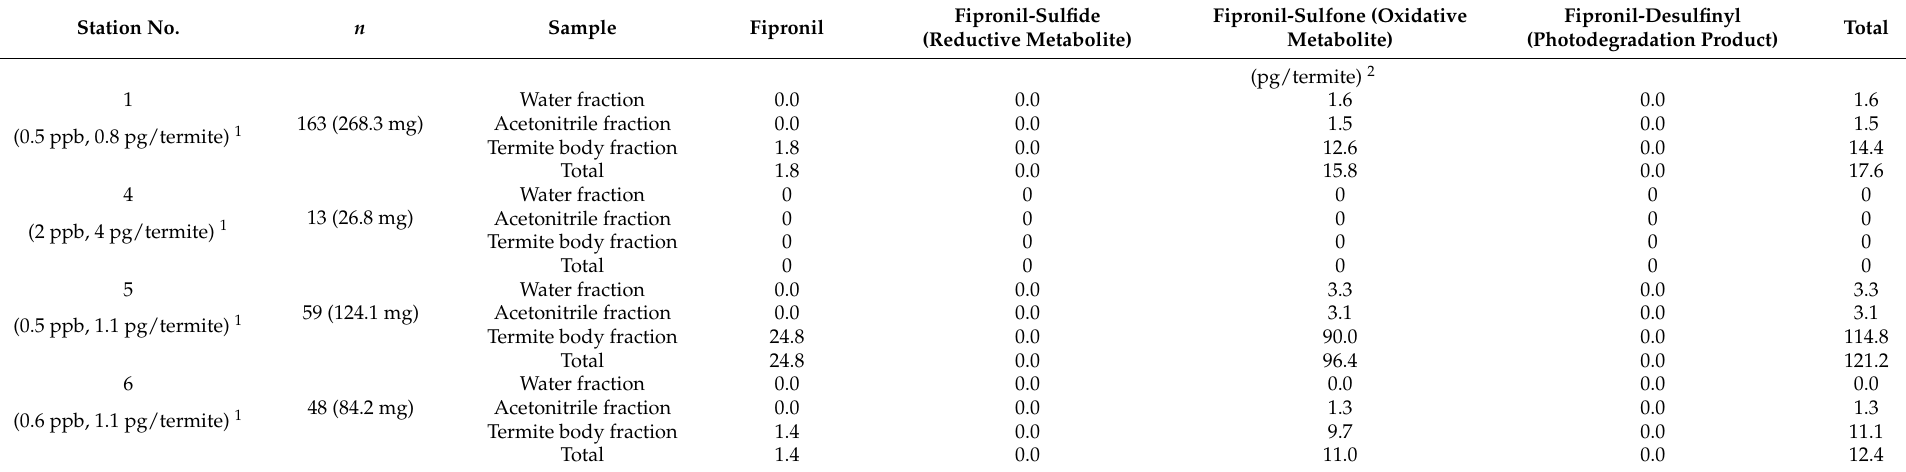
Table 5. Fipronil and its sulfide, sulfone, and desulfinyl derivatives detected from worker caste termites of Reticulitermes speratus collected at Kindai University four days after the soil treatment. Station